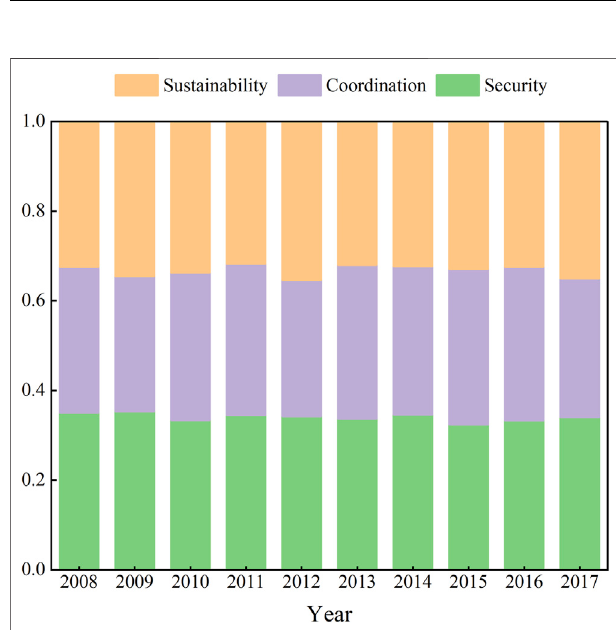
FIGURE 3 | Water-energy-food suitability trend for Sichuan province from 2008 to 2017. The range is divided into fi ve grades (bad, bad, moderate, good, and excellent, respectively) based on the calculated evaluation value of each item.